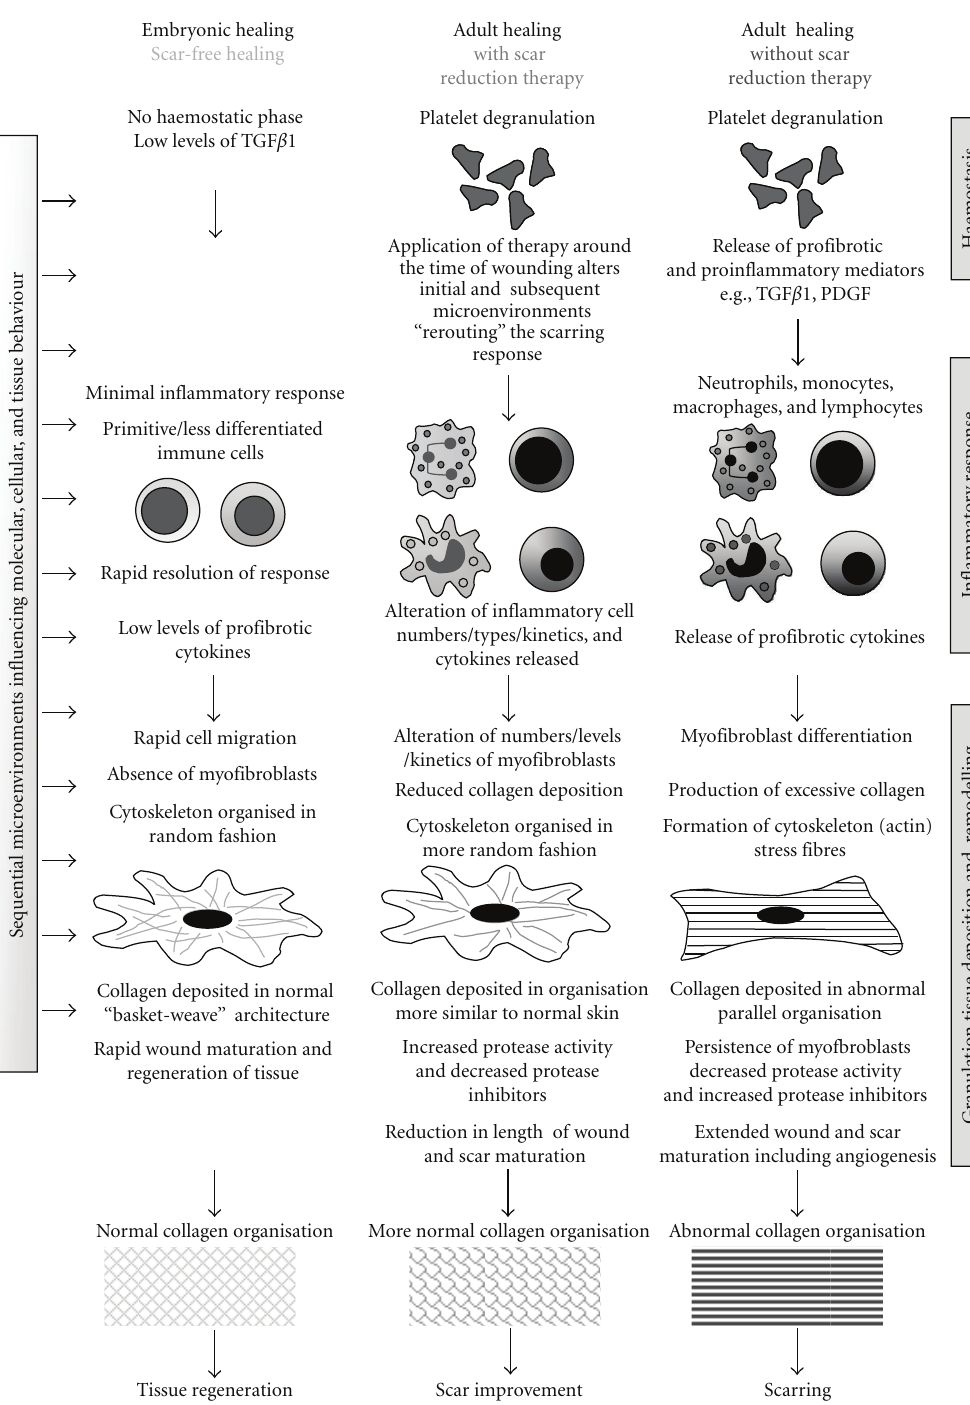
in the third study [59]. All investigators, participants, and scar assessors were blinded to treatment and e ffi cacy